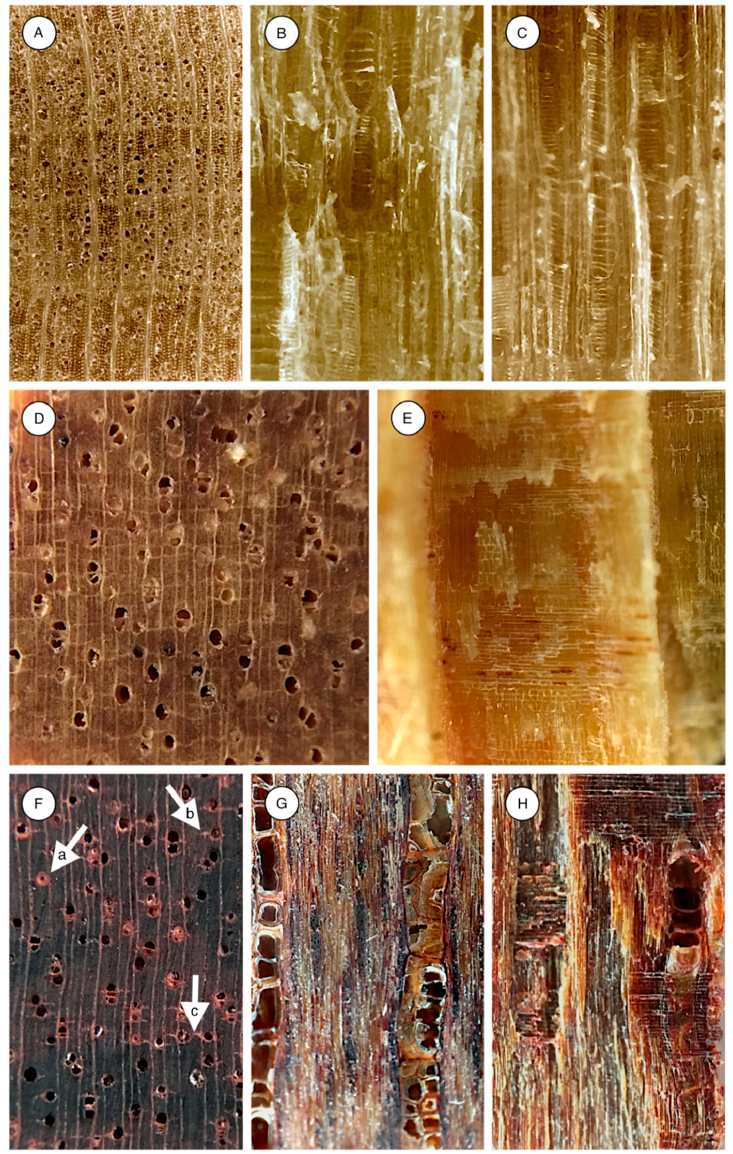
Figure 9. Elements visible with 400× lens in hardwoods. Magnolia liliifera var. obovata (Korth.) Govaerts. obovata . ( A ) Diffuse-porous wood. ( B ) Scalariform perforation plate. ( C ) Scalariform intervessel pits. Oreomunnea pterocarpa Oerst. ( D ) Axial parenchyma in narrow bands or lines up to 3 cells wide. ( E ) Procumbent body ray cells with mostly 2–4 rows of upright and/or square marginal cells and even with more than 4 rows. Paubrasilia echinata (Lam.) Gagnon, H.C. Lima & G.P. Lewis ( syn. Caesalpinia echinata Lam.). ( F ) ( a ) Deposits; ( b ) lozenge-aliform axial parenchyma; ( c ) confluent axial parenchyma. ( G ) Irregularly storied rays. ( H ) Homocellular rays with procumbent cells. Oreomunnea Oerst. comprises four species ( O. americana Lundell, O. mexicana (Standl.) J.-F.Leroy, O. munchiquensis Lozano and F.González and O. pterocarpa ), all native to Central America. Only O. pterocarpa , naturally distributed in Costa Rica, Mexico and Panama, is listed in CITES. It is traded only in the local area. It has diffuse-porous wood, with vessels visible without a magnifying lens, solitary and in multiples of two and three, with tyloses and without deposits. With a traditional